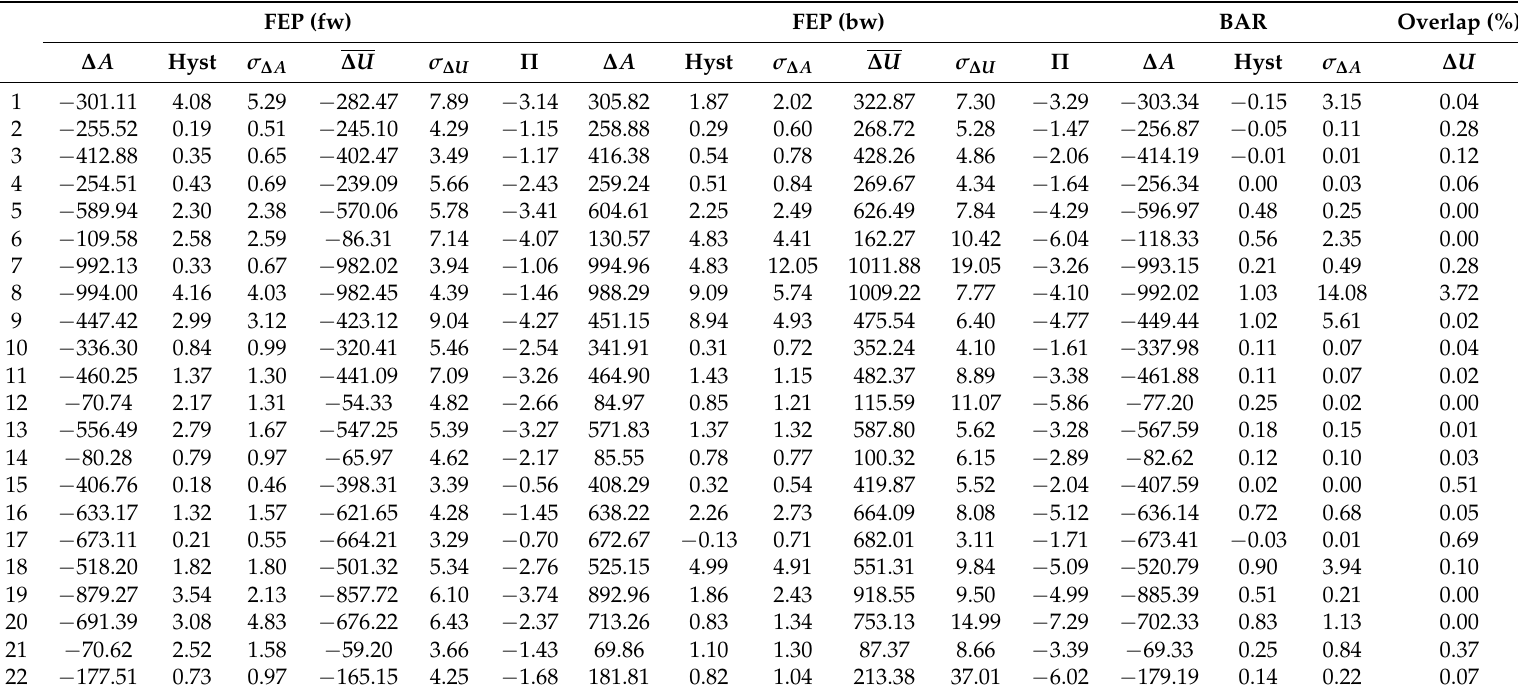
Table 2. Equilibrium results. ∆ A MM → 3 ob calculated with FEP (fw), FEP (bw), and BAR, as well as calculated convergence metrics. For each ∆ A , we divide the total dataset into 10 blocks, calculate ∆ A i from each of these i blocks, and compare the average of those ∆ A i to ∆ A calculated from the total dataset (giving Hyst ), and we also report the standard deviation of these ∆ A i ( σ ∆ A ). To determine the reliability of ∆ U distributions for calculating ∆ A we report: ∆ U , the standard deviation of ∆ U ’s ( σ ∆ Π which, when >0.5, likely indicates the ∆ U U ) as narrower distributions are likely to provide converged results, and finally we report one-sided